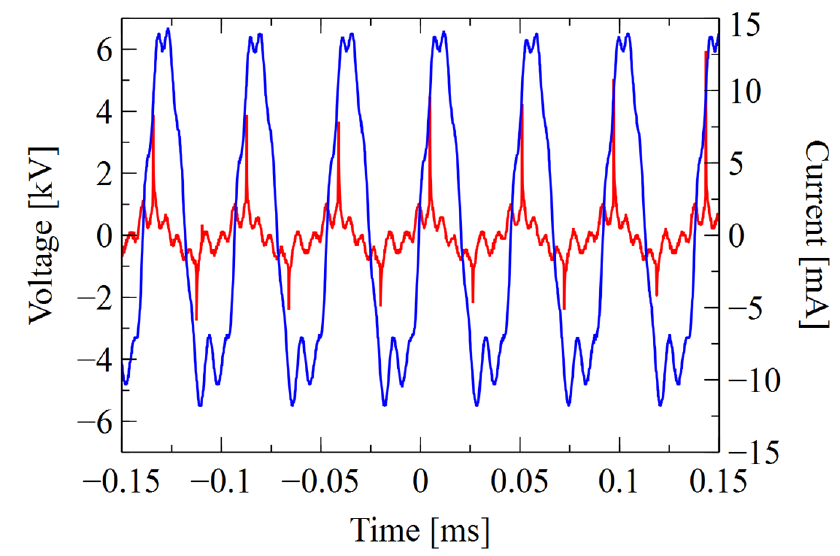
Figure 6. Waveform of voltage (blue line) and current (red line) for 1.5 L/min helium and 0.3 L/min oxygen mixture.